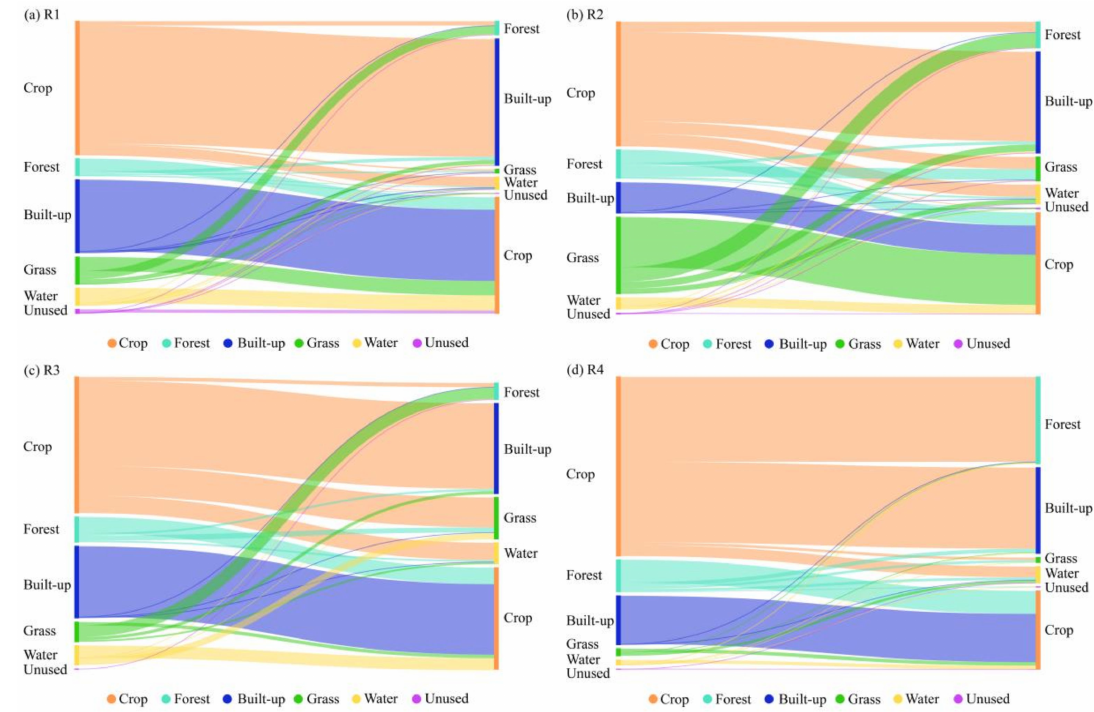
Figure 3. The flow pattern of LUCC in Henan Province from 1980 to